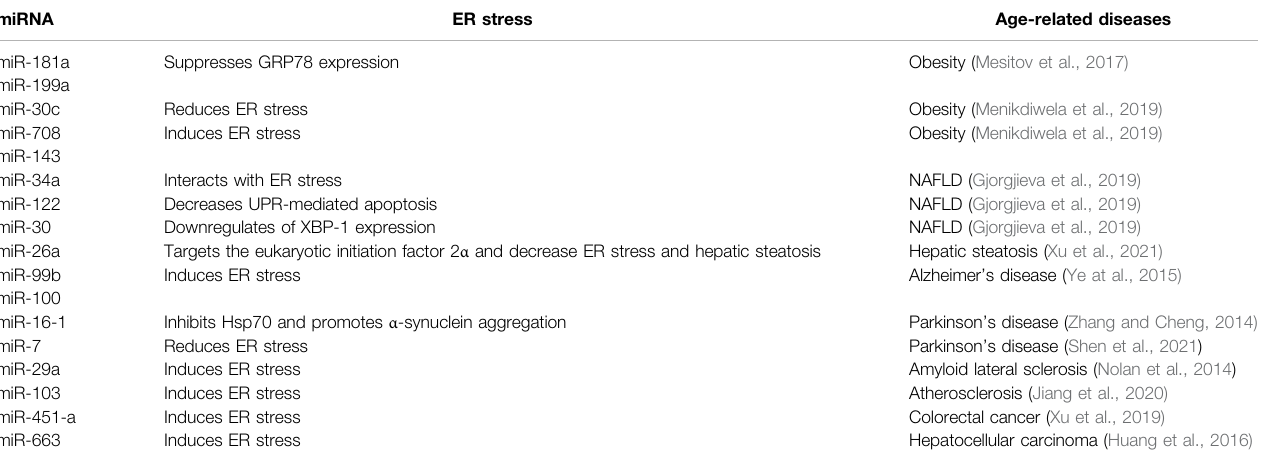
TABLE 1 | MicroRNA-mediated ER stress regulation during age-related diseases.